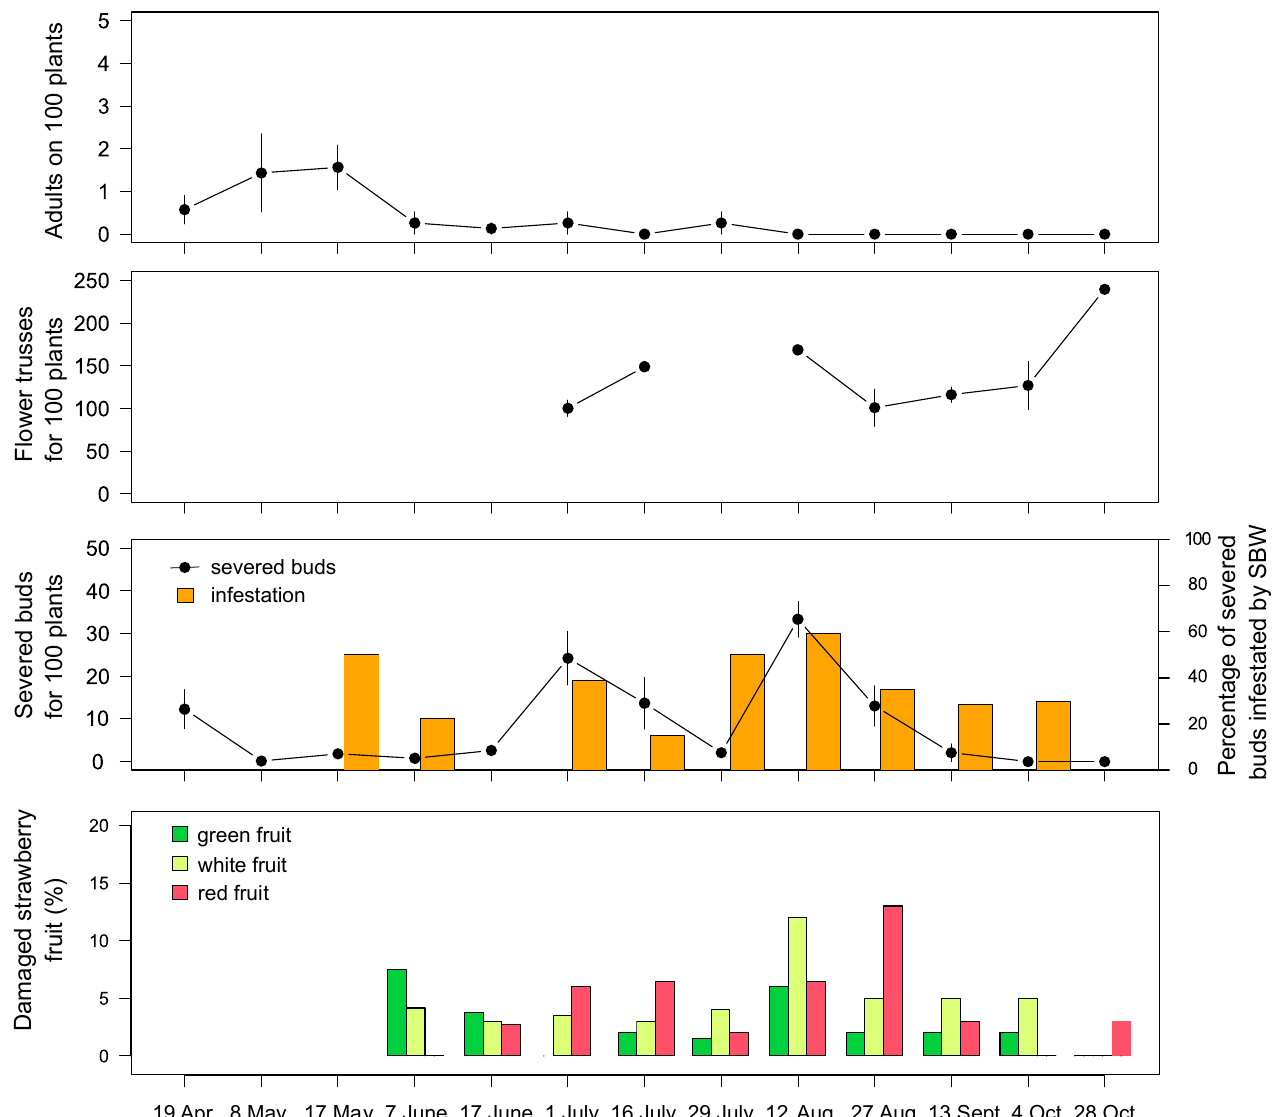
Figure 3. SBW adults, flower trusses, severed strawberry flower buds, percentage of severed buds infested by SBW, and fruit damage during the 2019 season in the field of Drena. Error bars indicate standard error.